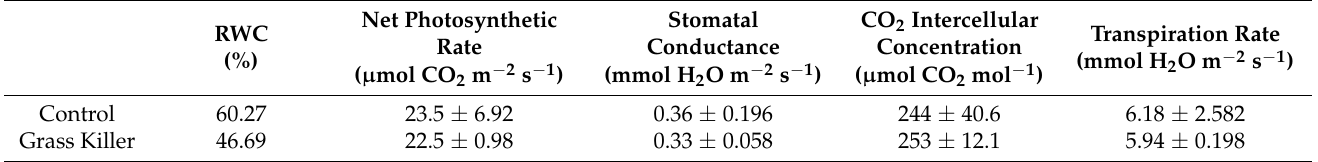
Table 4. Plant water status and diurnal leaf gas exchange registered at the beginning of August 2020 (48 days after the weed control treatment in the June test).